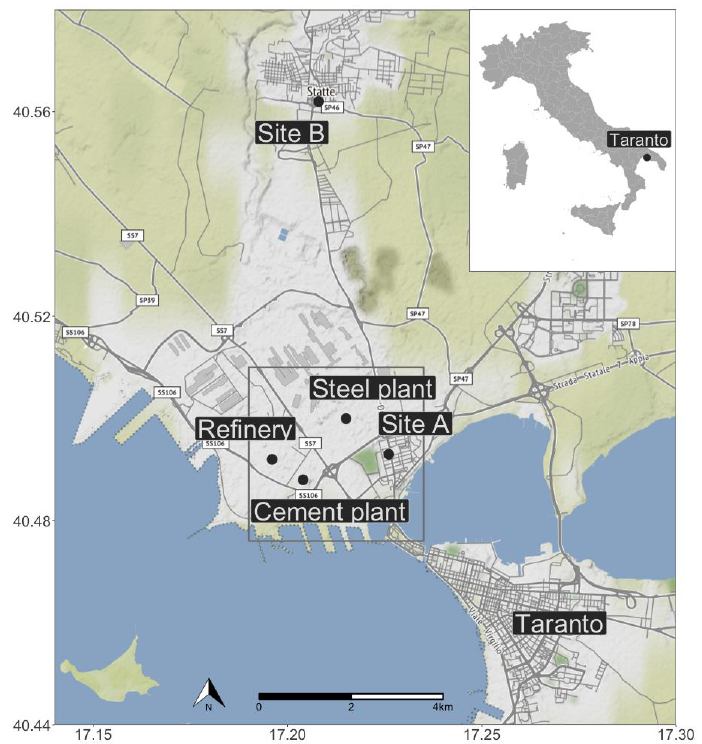
Figure 1. Location of the industrial area and of the sampling sites on the Taranto area map.